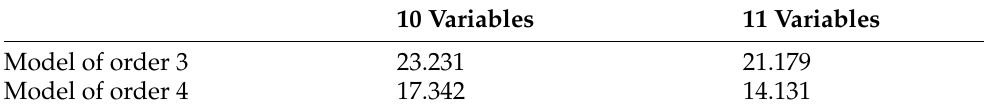
Table 5. RMSE values for the different input variables taken in the